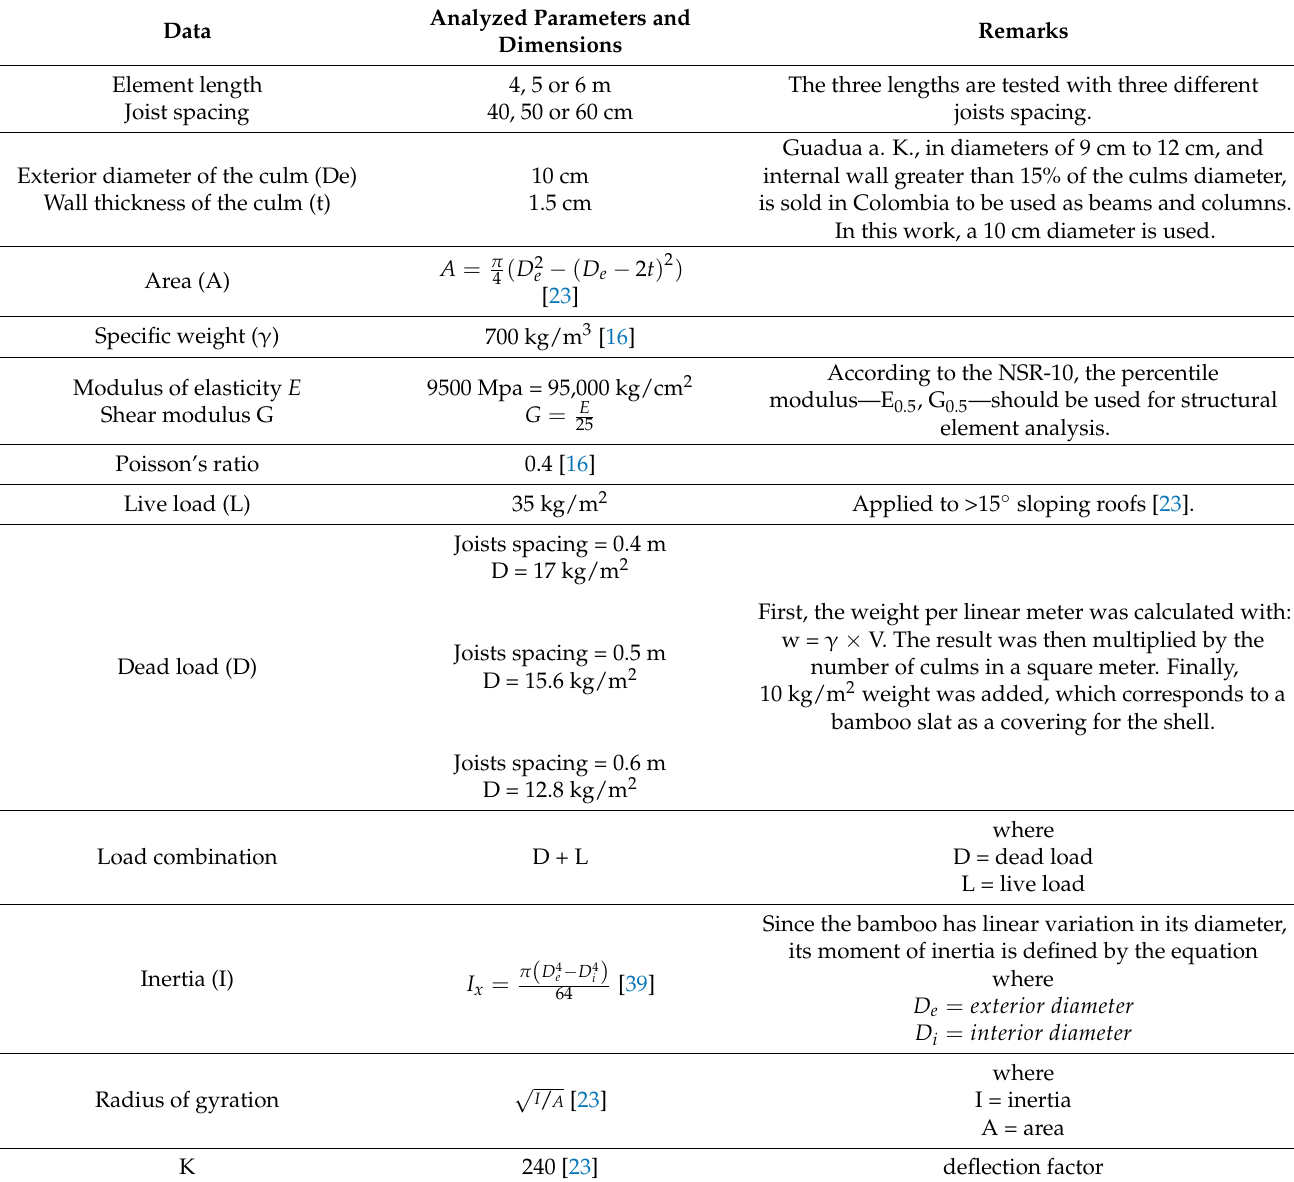
Table 3. Data and design